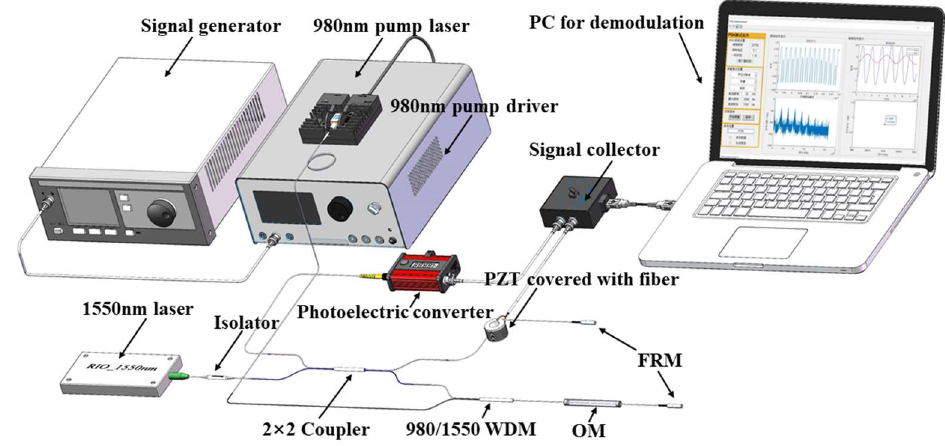
Figure 4. The setup of experiment.